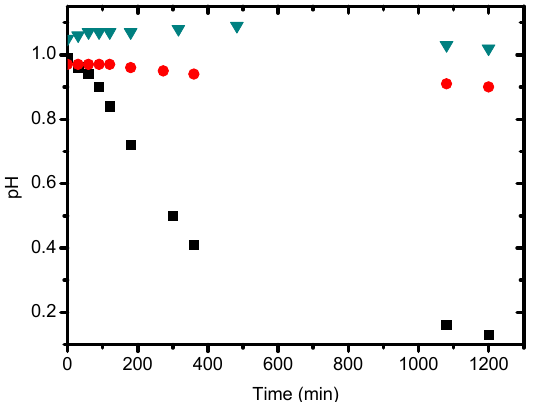
PIMSD. ( b ) is the replot of the data of ( a ) in log scale, and the small figure in ( b ) is the magnification